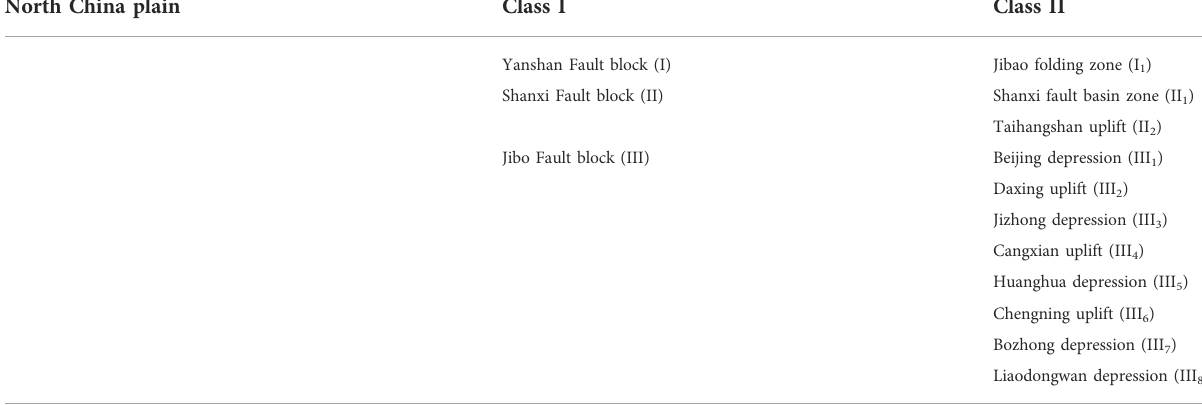
TABLE 1 Regional neotectonic unit